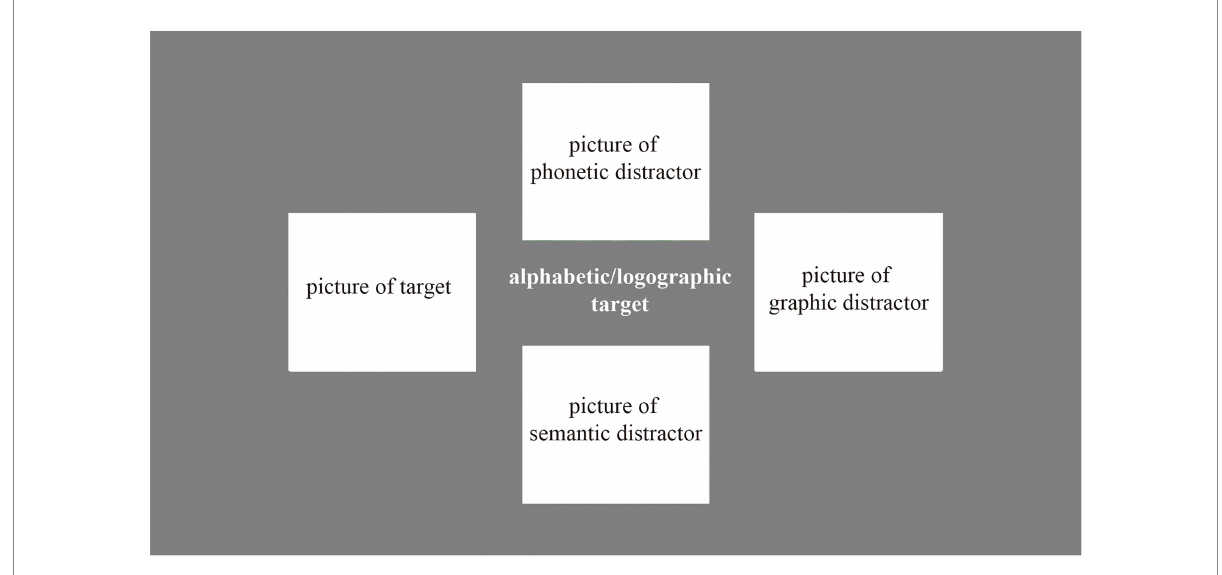
FIGURE 2 The target, semantic distractor, graphic distractor, and phonetic distractor for the alphabetic and logographic